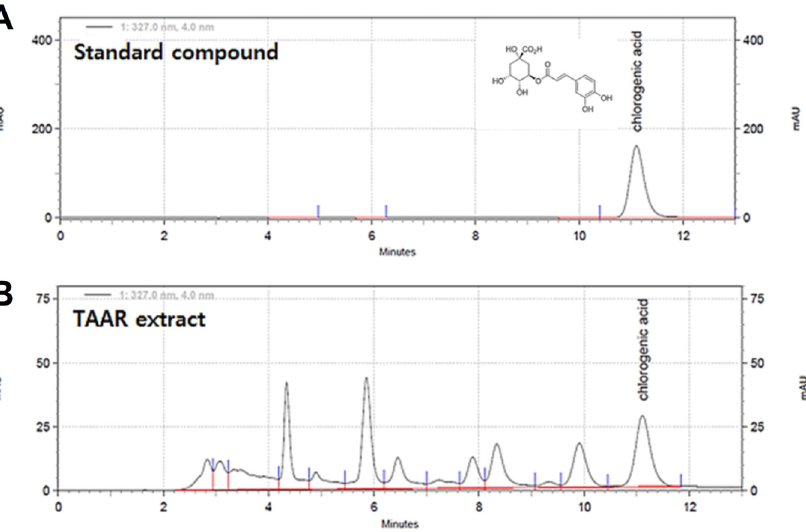
Figure 1. HPLC analysis of the TA and AR (TAAR) mixture extract. HPLC chromatograms of the ( A ) standard compound and ( B ) TAAR extract sample.